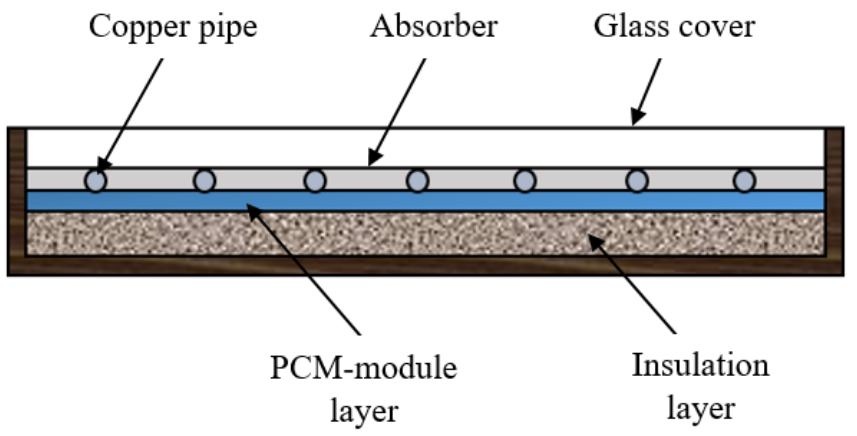
Figure 15. The cross-sectional sketch of an FPC modified with a PCM layer between the collector pipes and the insulation layer. Adapted with permission from ref. [131] 2019 Zhou et al.